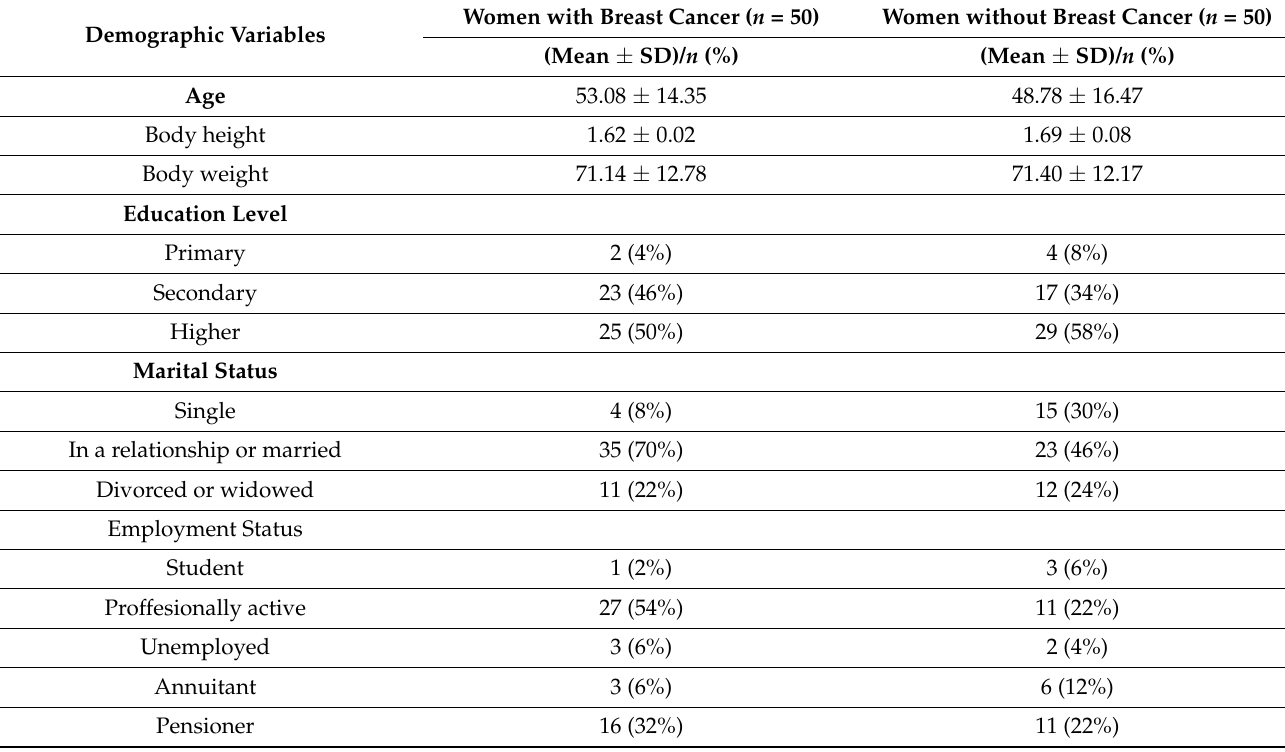
Table 1. Socio-demographic variables of